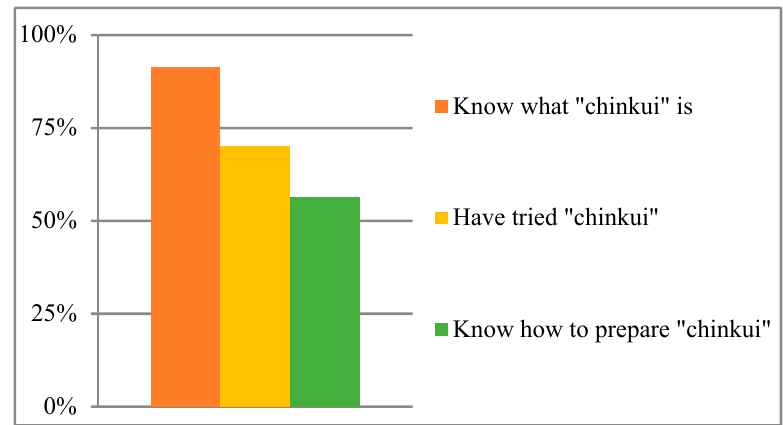
Figure 1. Knowledge of Bairro Boroma goat herders about chinkui.